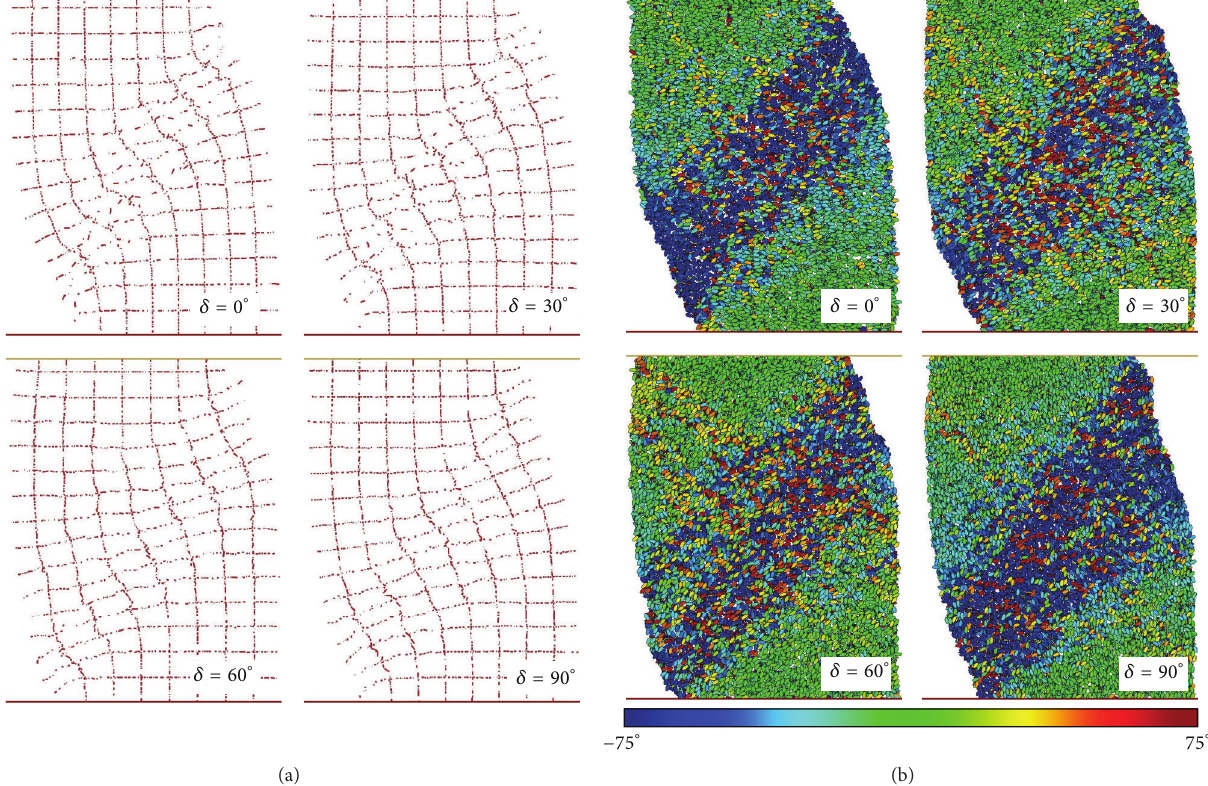
Figure 13: Deformation of biaxial compression tests at axial strain of 15% under Flexible boundary: (a) overall deformation and (b) contours of individual particle